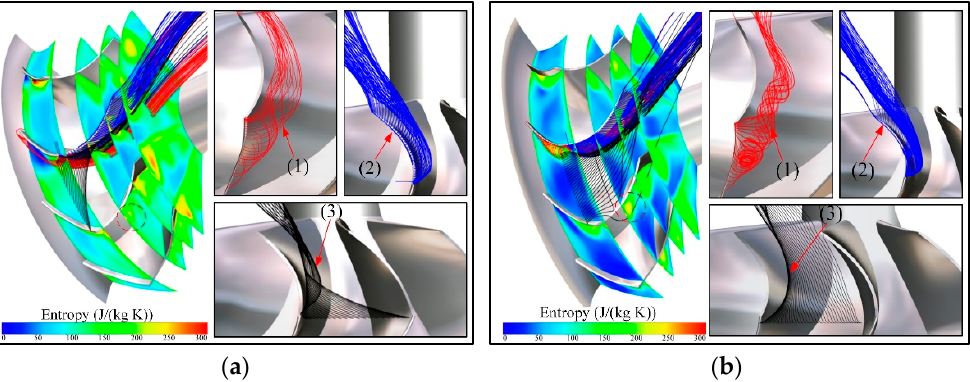
Figure 10. Flow and loss in the rotor for the two models at a 40% opening: ( a ) base model; ( b ) SSGV model. (1) Rotor leading edge vortex; (2) rotor tip leakage flow; (3) guide vane clearance leakage flow.